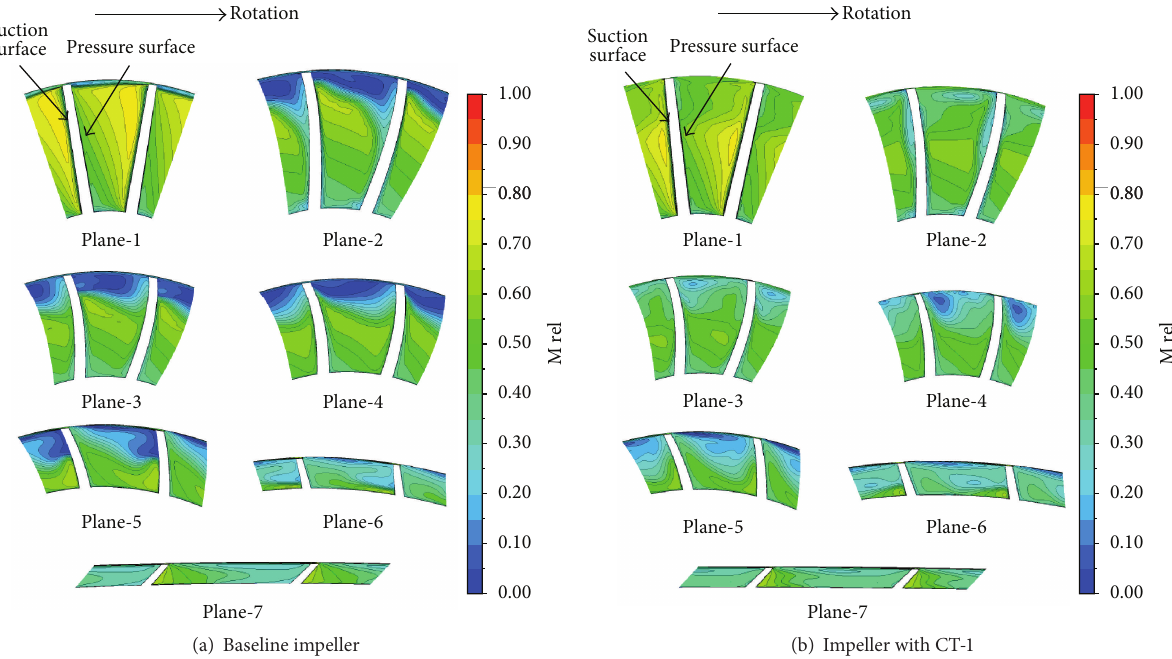
Figure 20: Relative Mach number distribution on streamwise planes of baseline and CT-1 impeller at stall mass flow rate of baseline